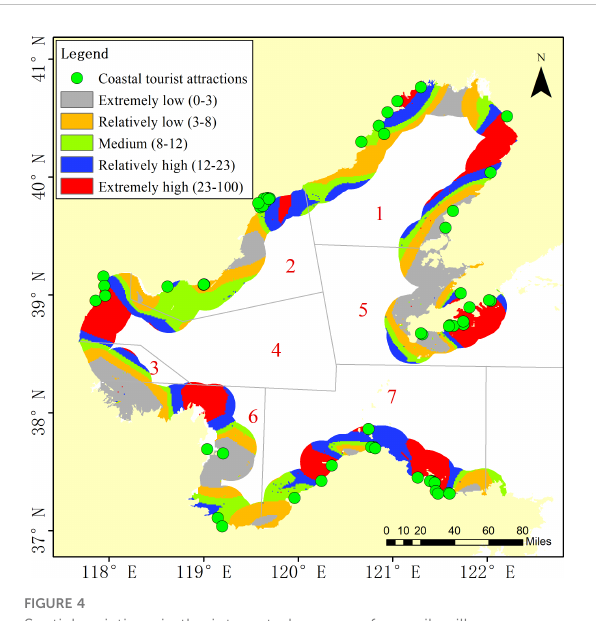
FIGURE 6 Spatial variations in the integrated response.